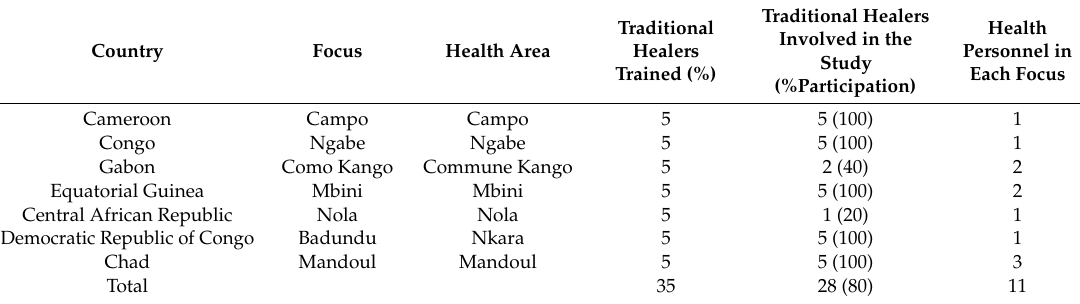
Table 1. Participation of Traditional Healers.